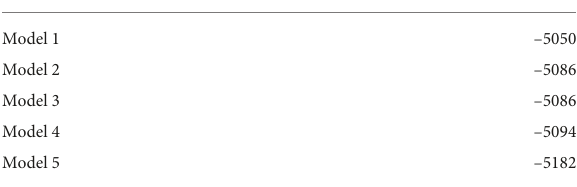
TABLE 1 Akaike information criterion (AIC) for different models.